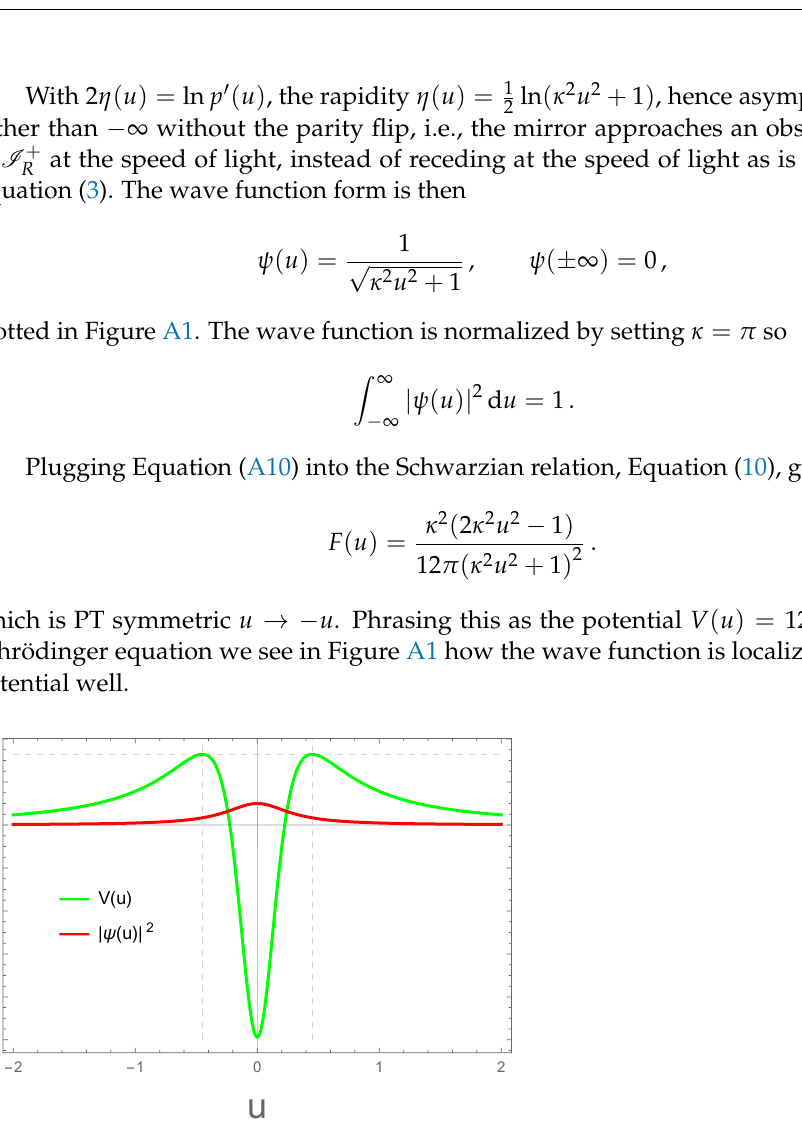
Figure A1. The potential Equation (A7) with Equation (A13), and the wave function Equation (A11). | ψ 2 | is normalized according to Equation (A12) where κ = π . The potential maxima occur at ±√ u m = 2/ κ with maximum value V m ( u m ) = κ 2 /3; the zero crossings are at u 0 = ± 1/ ( κ